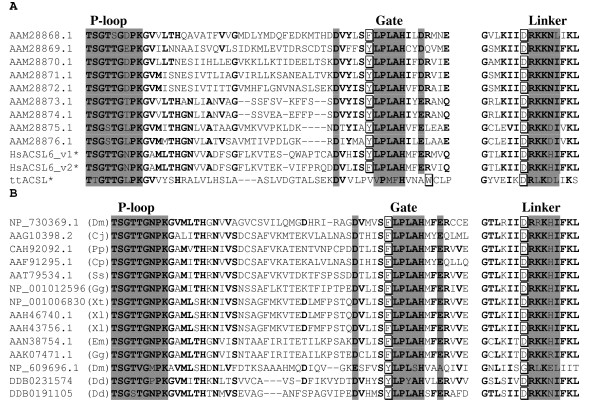
Conservation of the gate and linker motifs among ACSL homologs. A: Alignment of the nine Arabidopsis ACSL forms. Human ACSL6 spliced variant 1 and 2, and ACSL of Thermus thermophilus (ttACSL) indicated with an asterisk (*) are shown as references in the last three rows. B: Alignment of various forms of ACSL from different organisms. Abbreviations: Dm, Drosophila melanogaster (fly); Cj, Callithrix jacchus (marmoset); Pp, Pongo pygmaeus (orangutan); Cp, Cavia porcellus (guinea pig); Ss, Sus scrofa (pig); Gg, Gallus gallus (chicken); Xt, Xenopus tropicalis (frog); Xl, Xenopus laevis (frog); Em, Eleginops maclovinus (fish); Gg, Gobionotothen gibberifrons (fish); Dd, Dictyostelium discoideum (slime mould).